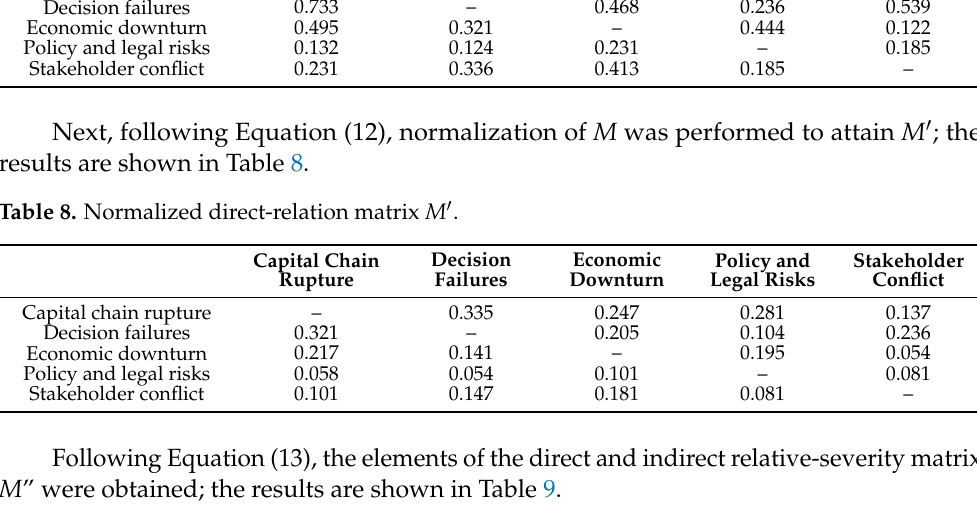
Table 9. Elements of direct and indirect relative-severity matrix M (cid:48)(cid:48)